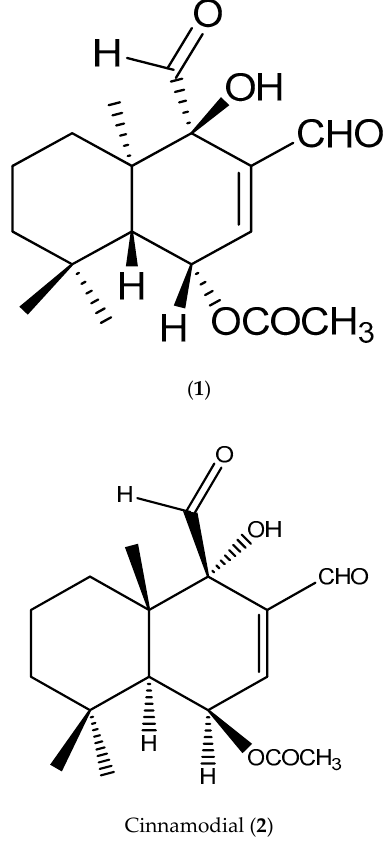
Figure 1. Structure of iso-mukaadial acetate ( 1 ) (chemical name: (1S,4R,4aR,8aR)-3,4-diformyl-4-hydroxy-4a,8,8-trimethyl-1,4,4a,5,6,7,8,8a-octahydronaphthalen-1-yl acetate) and Cinnamodial ( 2 ).